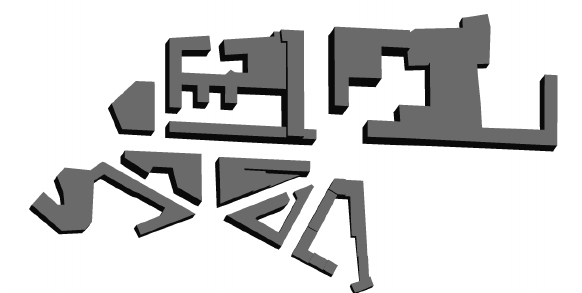
Figure 4. Healed and simplified city model of a building block in Stuttgart.